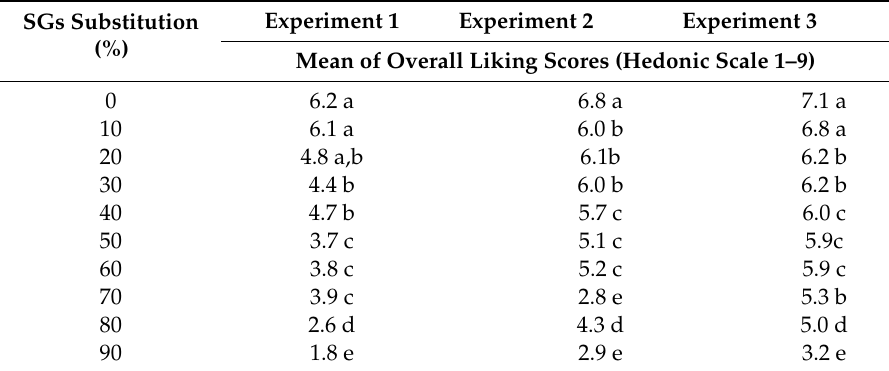
Table 3. The results of hedonic rating of apple preserves ( n =